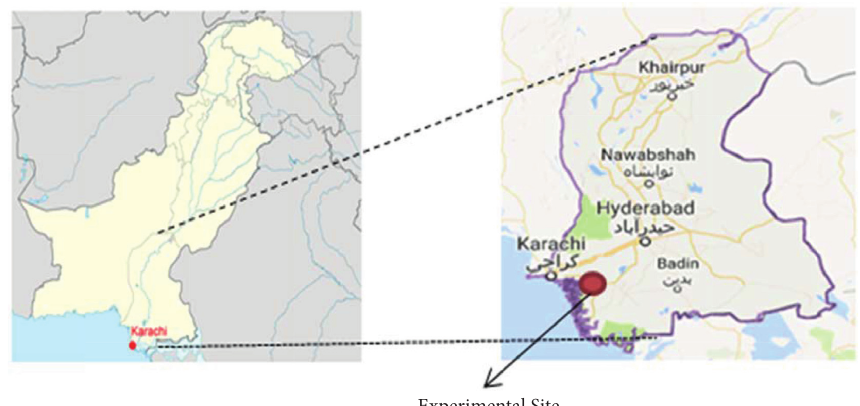
Figure 1: Location map of the experimental site.